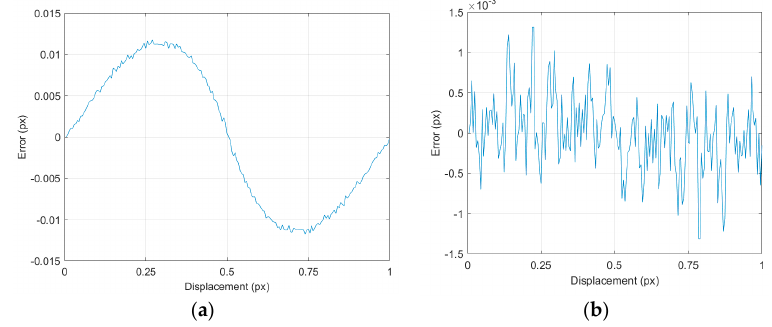
Figure 4. Example of the curve shape in the errors obtained: ( a ) big error, for a point size of 25 px, 43 intensity levels, and area ratio of 0.28, the maximum error is 0.01174 px; ( b ) small error, for a point size of 25 px, 232 intensity levels ,and area ratio of 3.84, the maximum error is 0.001315